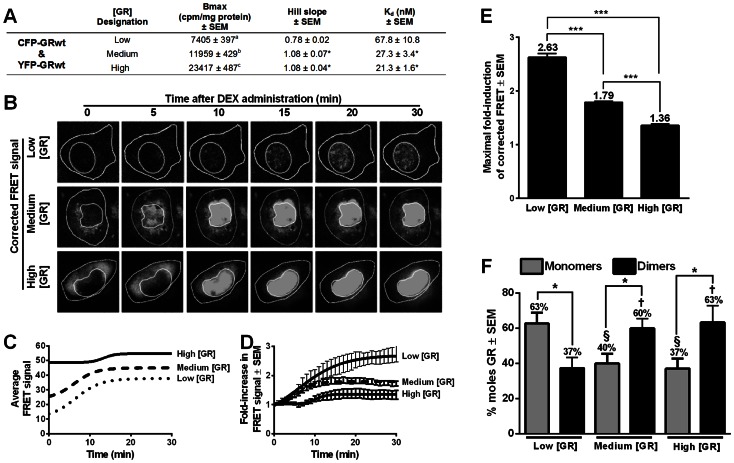
Ligand-induced dimerization decreases as GRwt concentration increases reflecting a higher percentage of ligand-independent dimerization.COS-1 cells were transiently transfected with CFP-GRwt and YFP-GRwt (low, medium or high levels). (A) Summary table of CFP-GRwt and YFP-GRwt saturation binding results. Statistical analysis of maximal binding (Bmax) compared to GRwt levels (Fig. 2C) was carried out using one-way ANOVA followed by Newman-Keuls post-test for Bmax. Conditions with different letters are statistically different from one another (P<0.01). For Hill slope and Kd, Newman-Keuls post-test (P*<0.05) against the low GR concentration condition was performed. Results represent a minimum of two independent experiments performed in triplicate (±SEM). (B–F) FRET was carried out on cells expressing CFP-GRwt and YFP-GRwt at low, medium or high concentrations. Cells were treated with 10-6 M DEX for 30 minutes while F-don, F-acc and FRET was monitored at 37°C. (B) Representative corrected FRET signals from cells expressing CFP-GRwt and YFP-GRwt at low, medium and high levels. The outer white lines in the FRET images designate the cellular membrane which has been used as the ROI. The nucleus in each cell has also been delineated with a white line. (C) Average FRET signal plotted against time and fitted to a sigmoidal dose-response variable slope curve. (D) Fold-increase in FRET response was calculated by normalizing each experiment to its un-stimulated FRET signal and fitted to a sigmoidal dose-response variable slope curve which generates (E) maximal fold-induction of FRET. Statistical analysis was carried out using one-way ANOVA followed by Newman-Keuls multiple comparison test (***P<0.001). (F) Mathematical derivation of FRET data (supplementary information in File S1) yields percentage moles of GR occurring as either monomers or homodimers prior to ligand stimulation. Statistical analysis was through one-way ANOVA followed by Dunnett's post-test against low GR concentration within monomers (§P<0.05) or dimers (†P<0.05) and two tailed unpaired t tests comparing percentage monomers against percentage dimers at each GR concentration (*P<0.05). Results from C–E are representative of seven independent experiments (±SEM), while results in (F) represent a minimum of four independent experiments (±SEM).